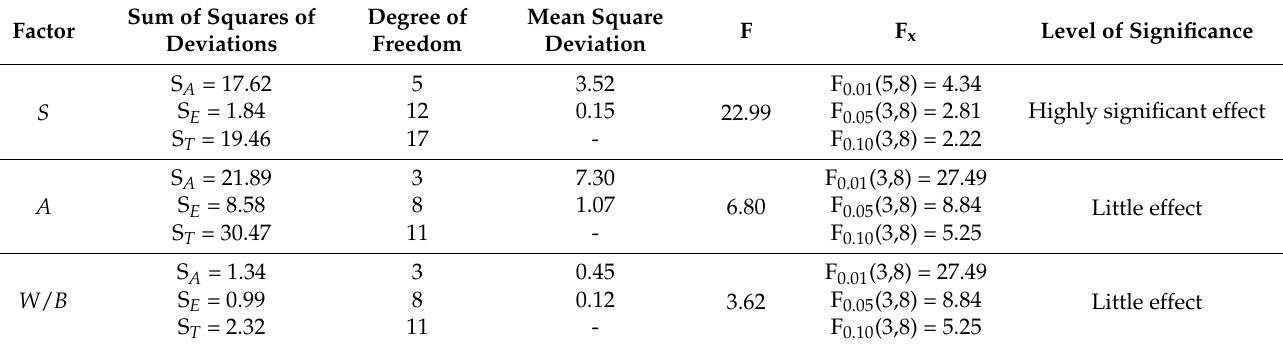
Table 4. Variance analysis of the flexural